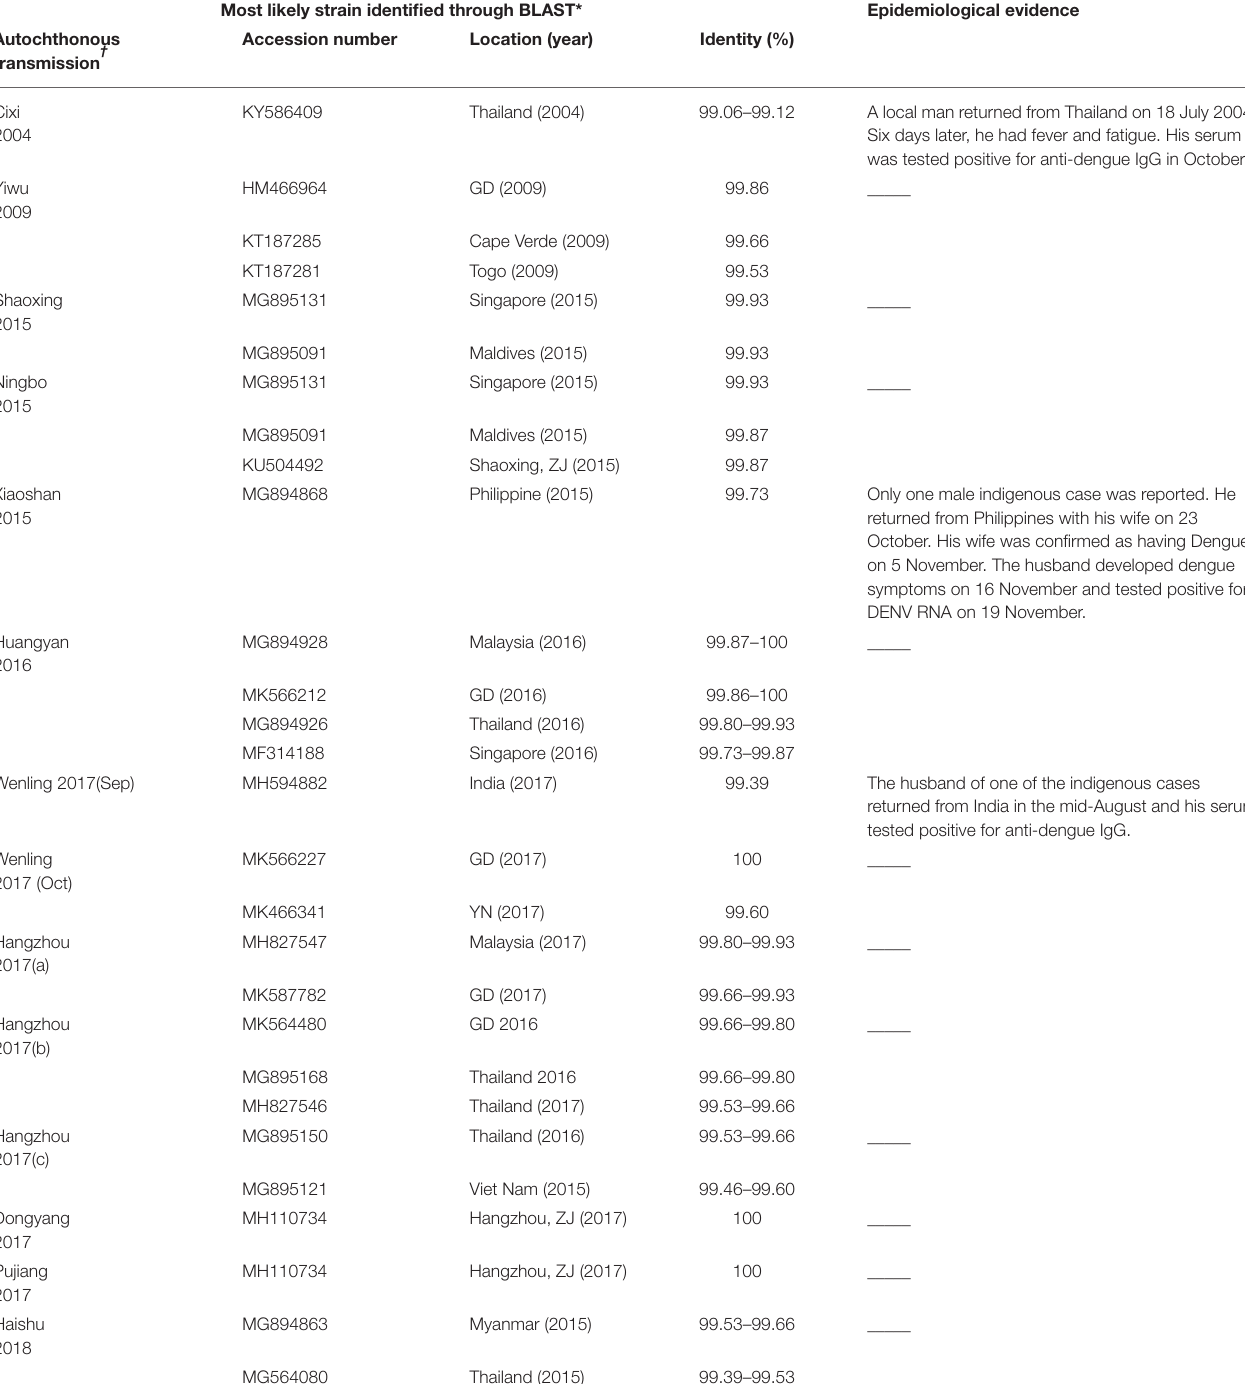
TABLE 3 | Source tracing of autochthonous transmission of Dengue in Zhejiang Province. Most likely strain identified through BLAST* Epidemiological evidence Autochthonous transmission